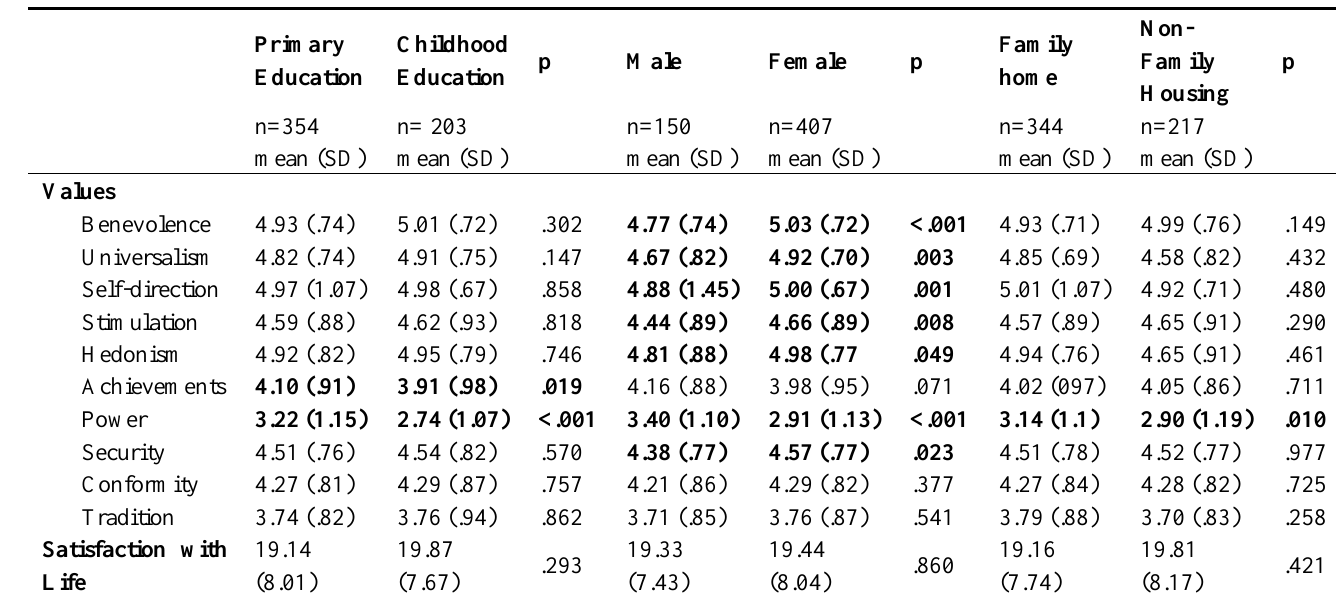
Values by Education program, gender and living